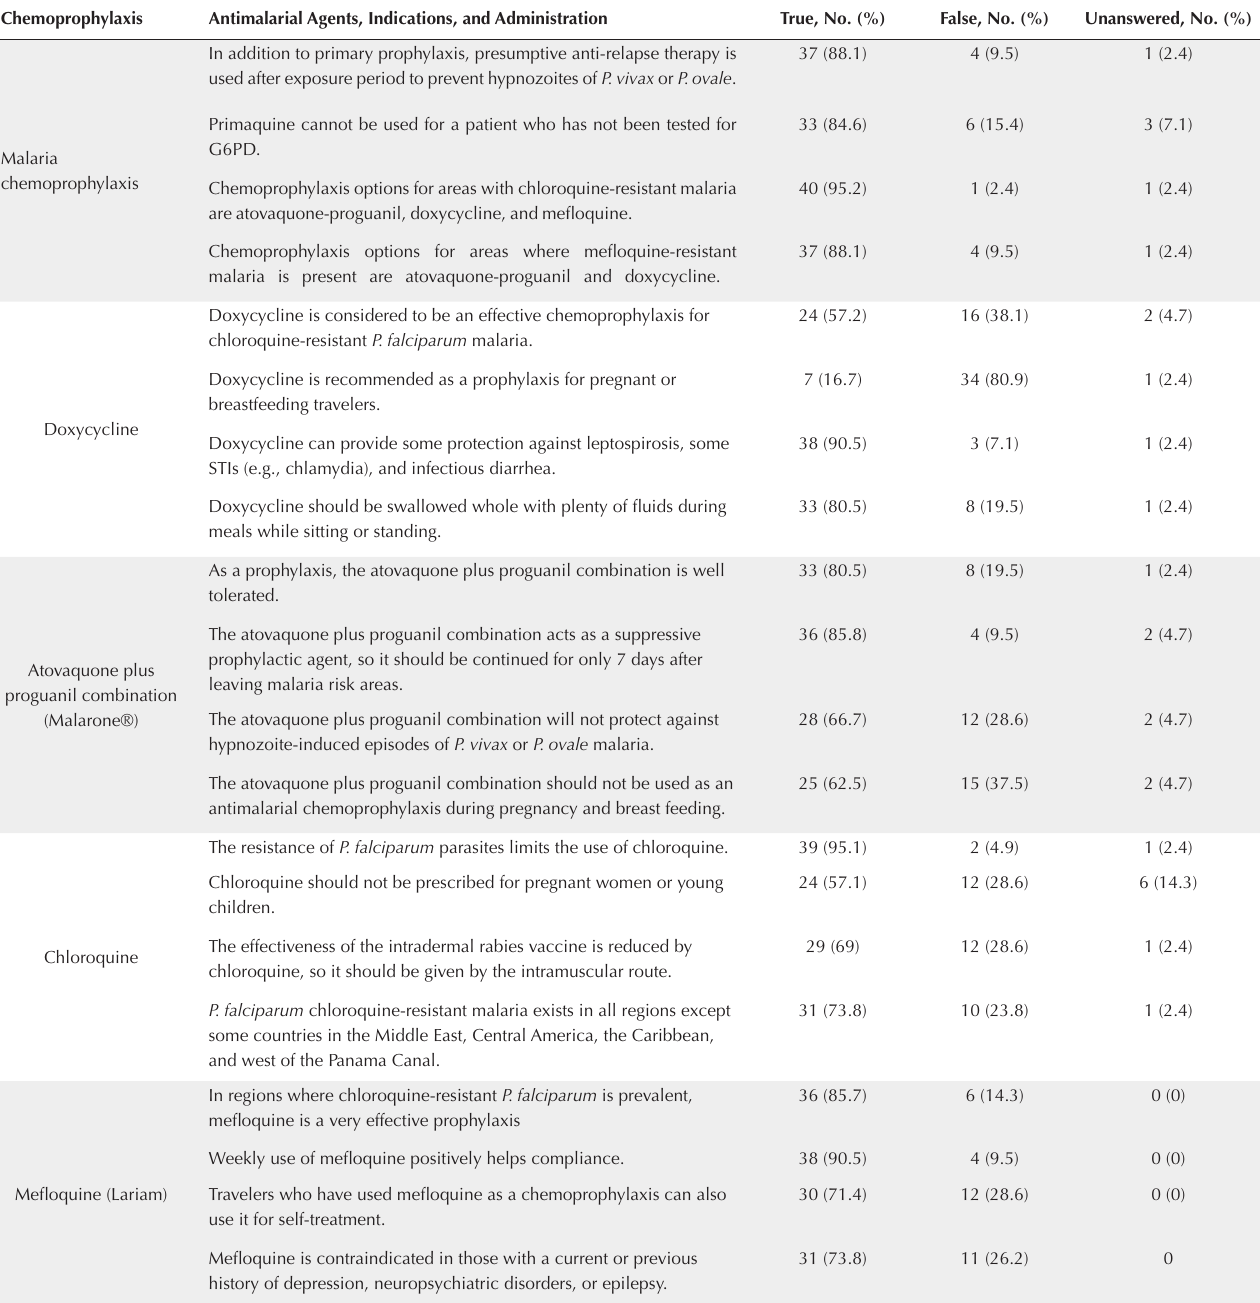
Table 5. Knowledge of Malarial Chemoprophylaxis Among Study Physicians in the State of Qatar Chemoprophylaxis Antimalarial Agents, Indications, and Administration True, No. (%) False, No. (%) Unanswered, No. (%)